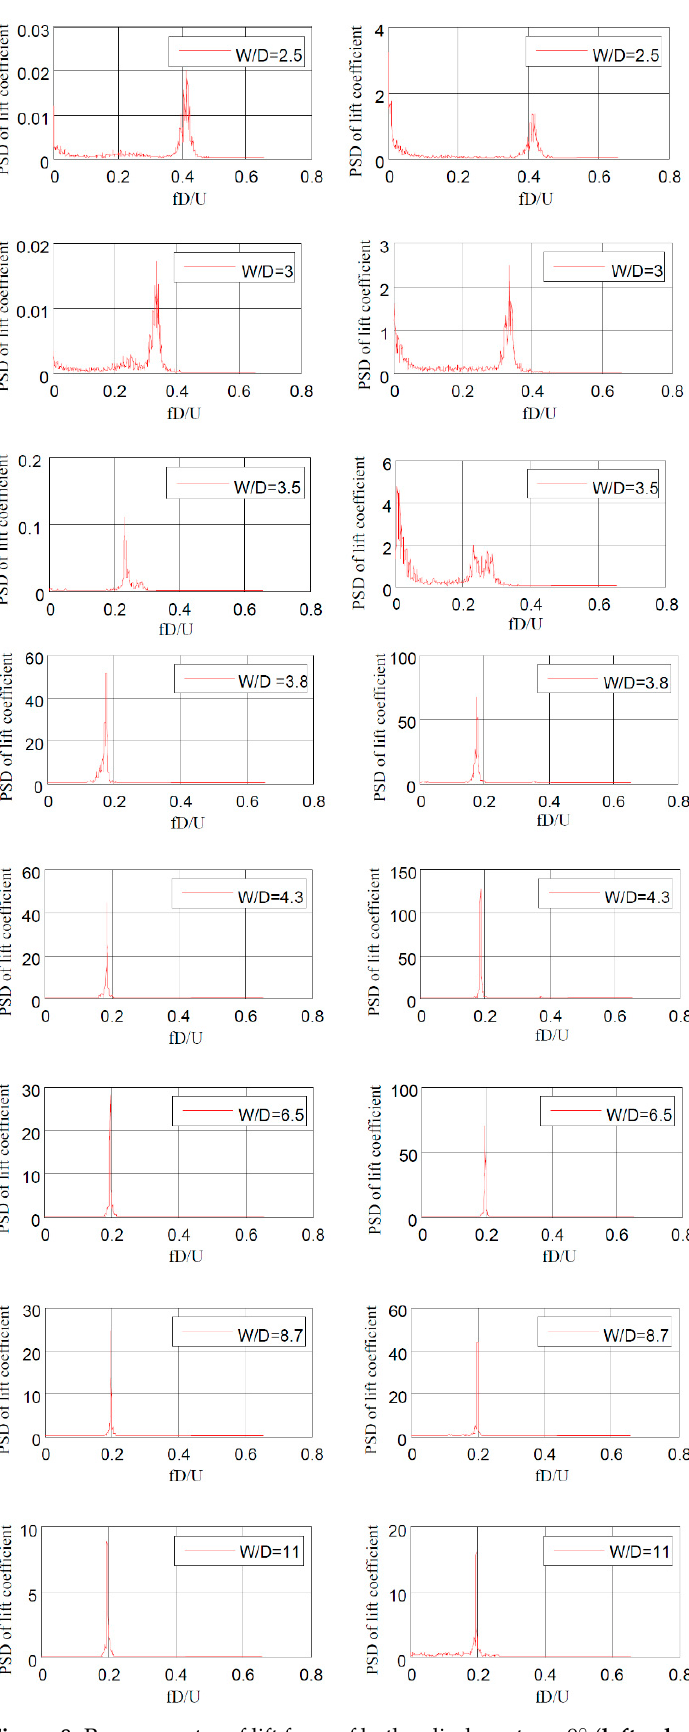
Figure 8. Power spectra of lift force of both cylinders at α = 9° ( left column : upstream cylinder; right column : downstream cylinder).